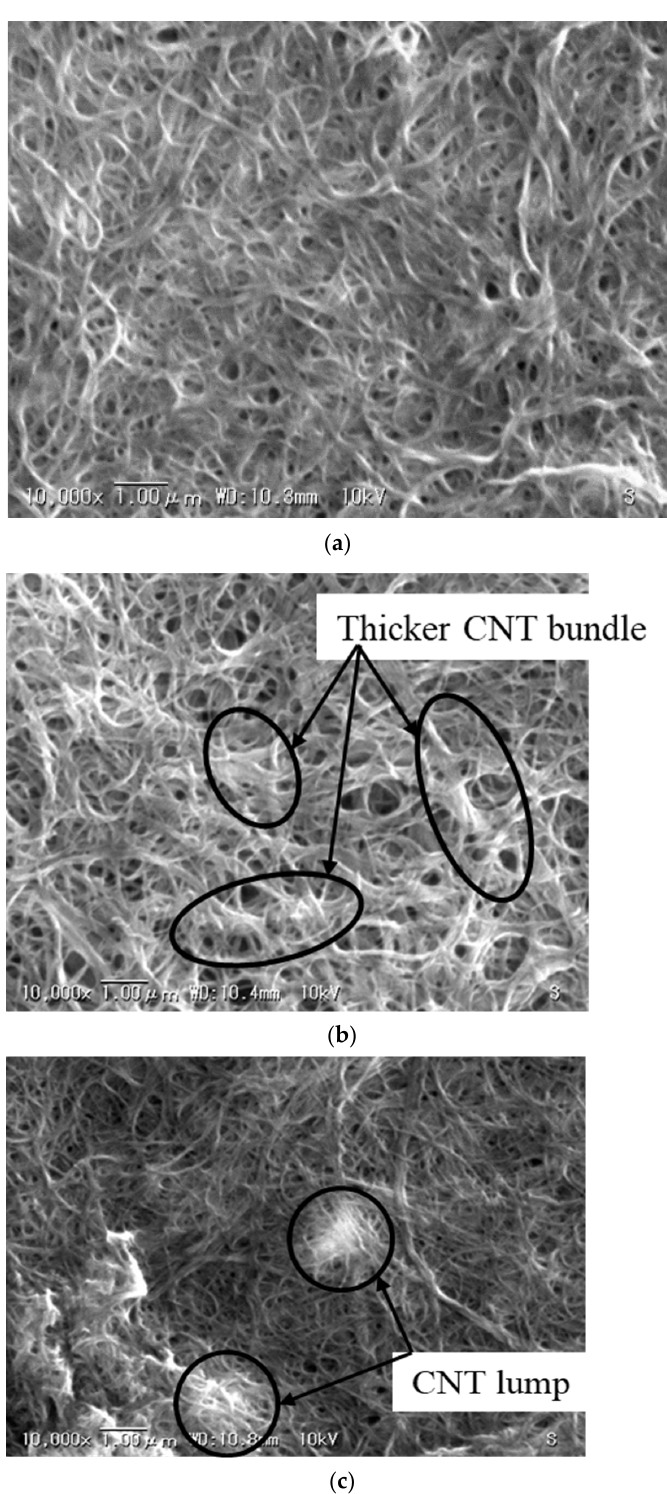
Figure 8. Comparison of degree of dispersion by dispersants ( a ) SDS, ( b ) polysorbate 20, and ( c ) catechin. ( c )